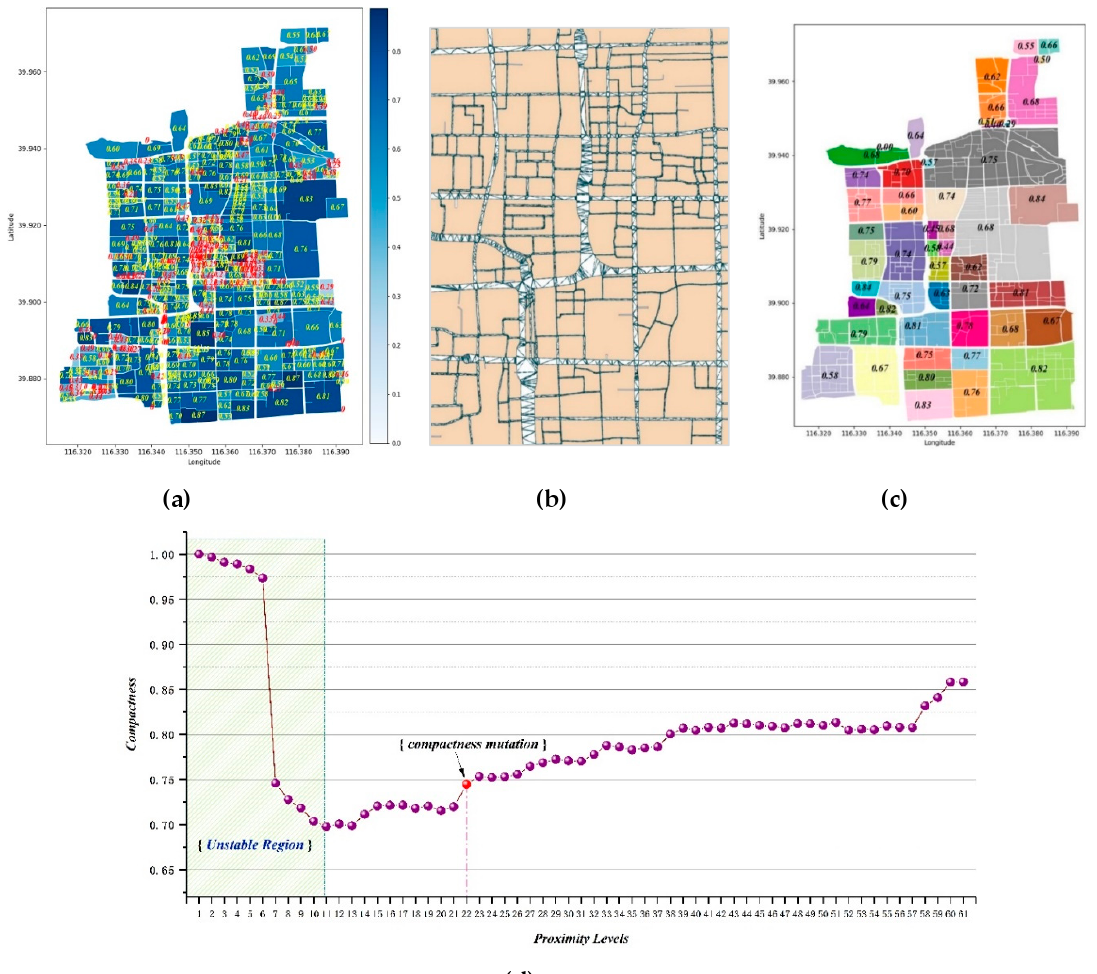
Figure 19. Xicheng District’s parcel grouping results are generated by UGP: ( a ) mixed land use of Xicheng District (red numbers within parcels represent the MLU less than 0.5); ( b ) a CDT constructed for the study area; ( c ) parcel grouping result at level 22, numbers within groups represent the MLU index; and ( d ) compactness curve.